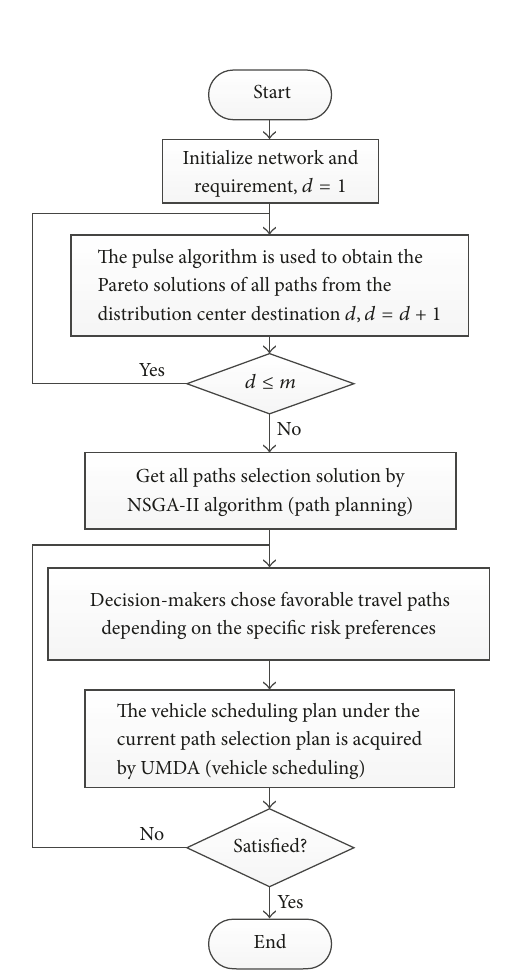
Figure 4: Flow chart for solving problem of path planning and vehicle scheduling of hazardous materials transportation.